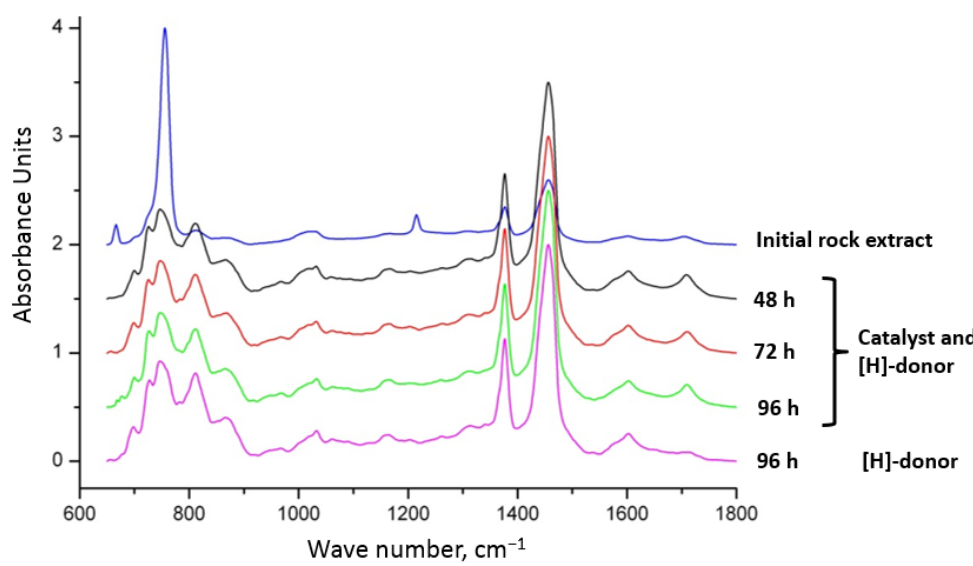
Figure 8. FT-IR of core extracts depending on the duration of catalytic hydrothermal treatment at 300 °C.